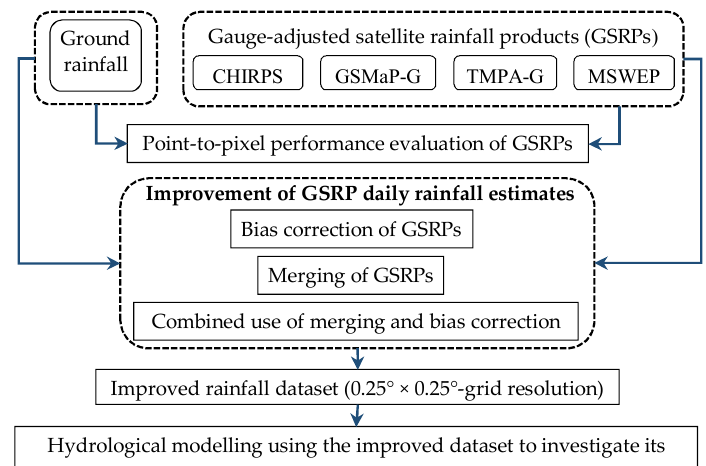
Figure 3. Flow chart of the research structure used in this study for comparing four GSRPs, creating a reference rainfall dataset, and investigating that dataset’s applicability when simulating streamflows